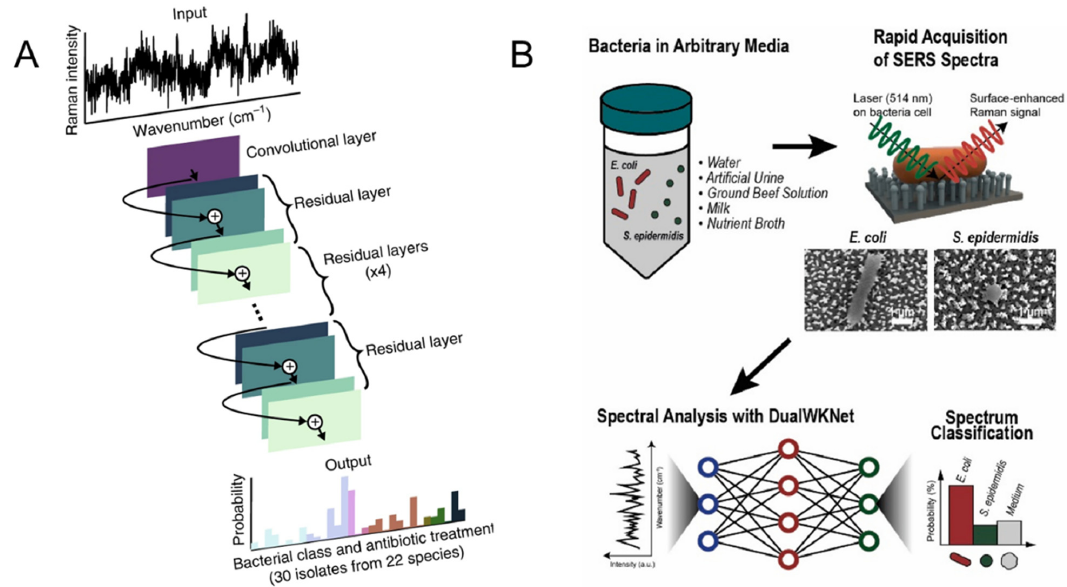
Figure 9. SERS combined with deep learning. ( A ) Using a one-dimensional residual network, low- signal Raman spectra are classified, which are then grouped by empiric antibiotic treatment [104]; ( B ) schematics of the general process of Raman data collection and analysis where a single spectrum is attained from a single cell and classified via deep learning, adapted with permission from [105].